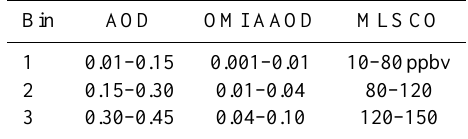
Table 1. AOD, AAOD, and 215hPa CO bins used in this